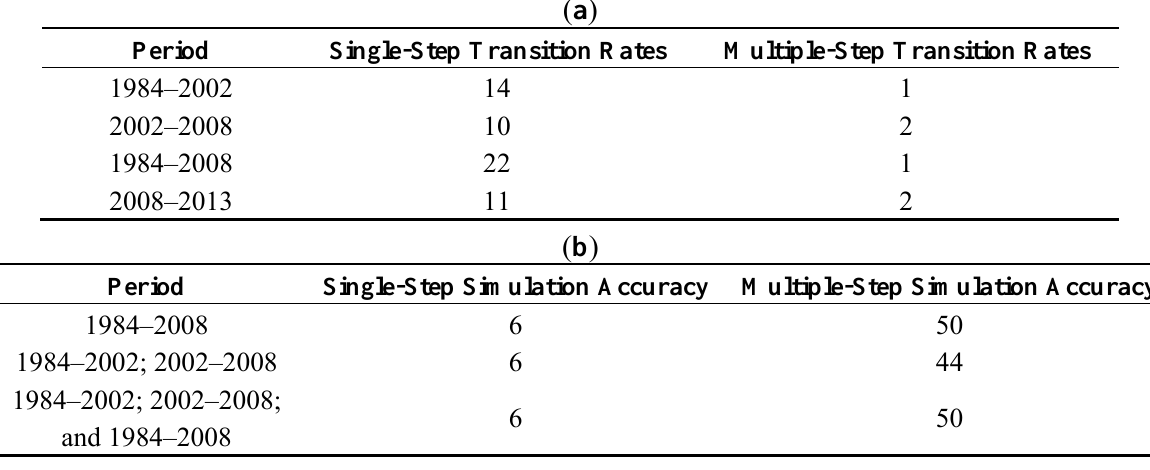
Table 3. ( a ) Single and multiple-step transition rates (%); ( b ) Simulation accuracy based on s ingle and multiple-step transition rates